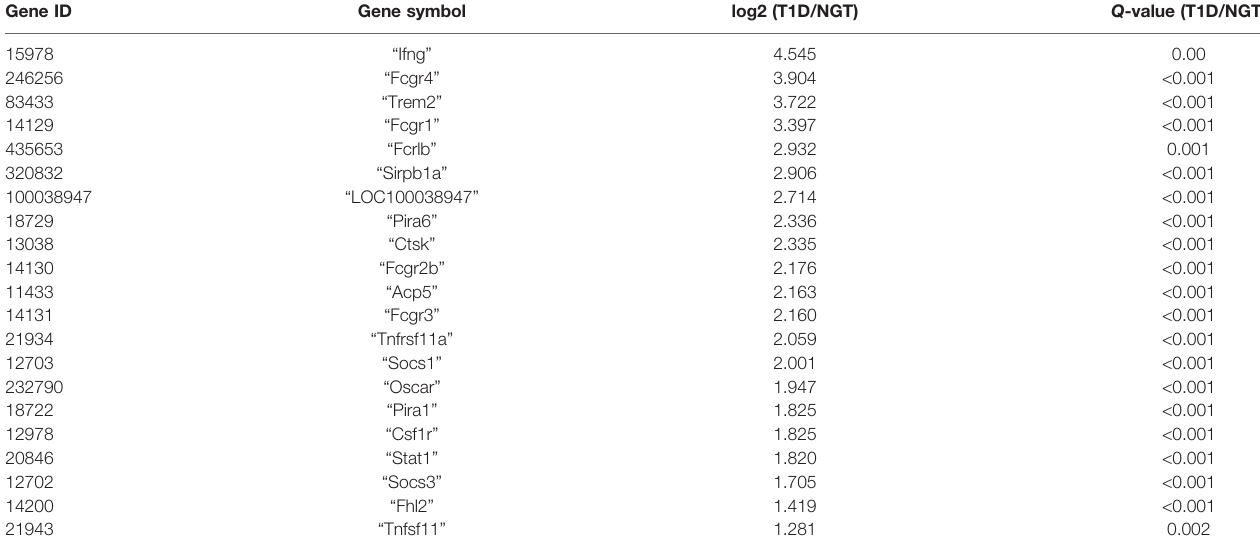
TABLE 4 | Signi fi cantly enriched DEGs in the osteoclastogenesis pathway. Gene